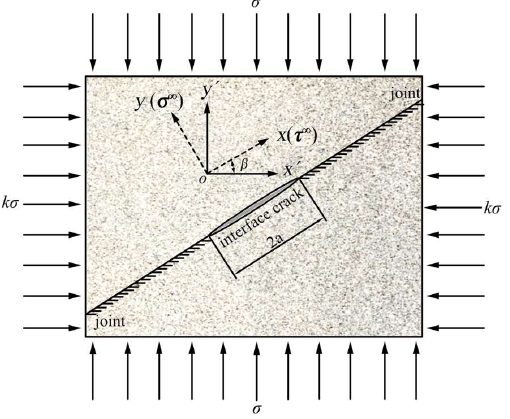
Figure 1. Interface crack model.